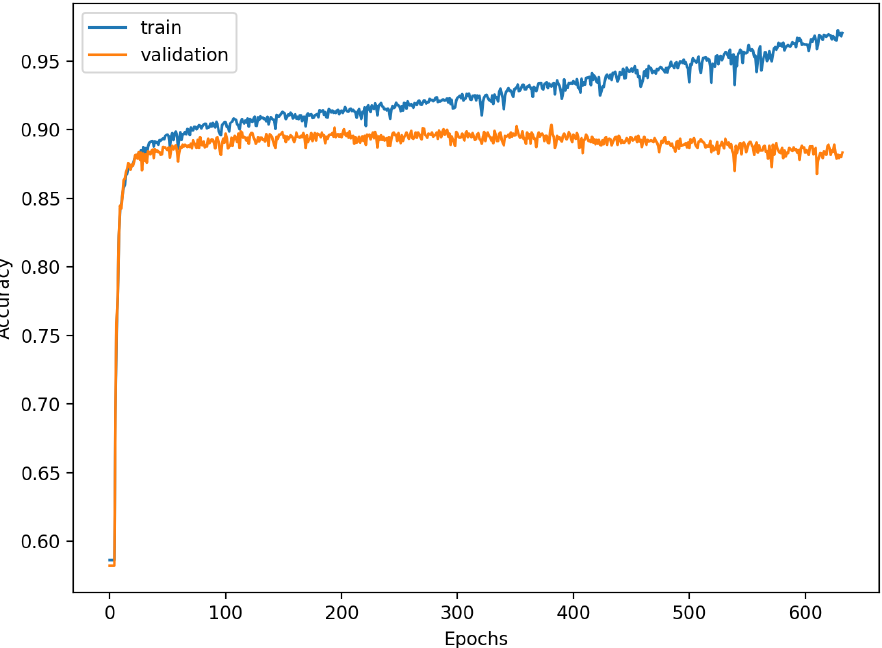
Figure 18. Learning process of the Neural Network for softmax-based classification (2